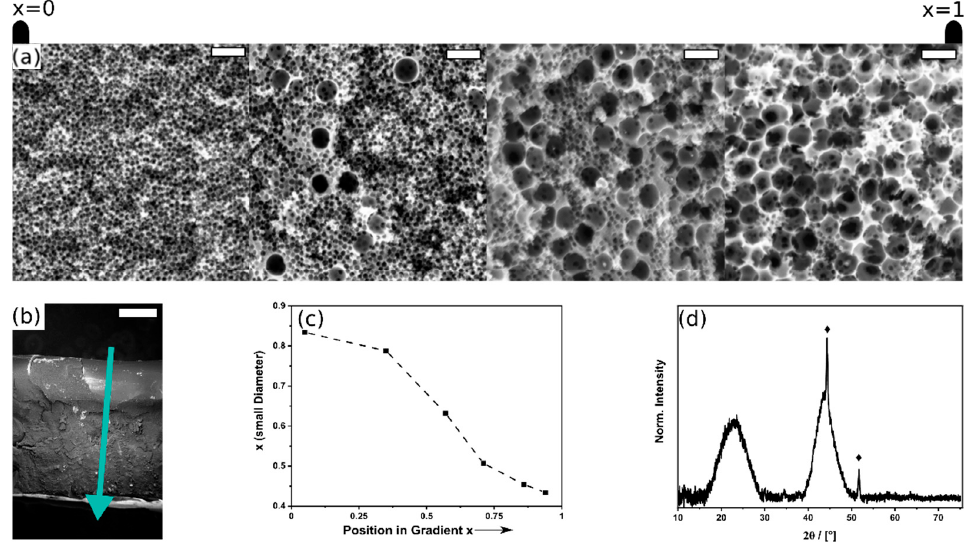
Figure 1. Ni@C material synthesized using PSS-137 and PSS-480 and a modified Ni 2+ -salen complex. ( a ) SEM micrographs (scale bar: 500 nm) taken along the cross-section and ( b ) SEM micrograph of the cross-section (scale bar = 200 µ m); arrow indicates the direction of the centrifugal force (start corresponds to x = 0; end, to x = 1). ( c ) Fraction of small pores along the gradient region as indicated in the cross-section determined by trainable Weka segmentation. ( d ) powder X-ray diffraction (PXRD) of a homogenized Ni@C sample, marked signals representing crystalline Ni. The gradient porosity is clearly observable in the micrographs, as only small pores,